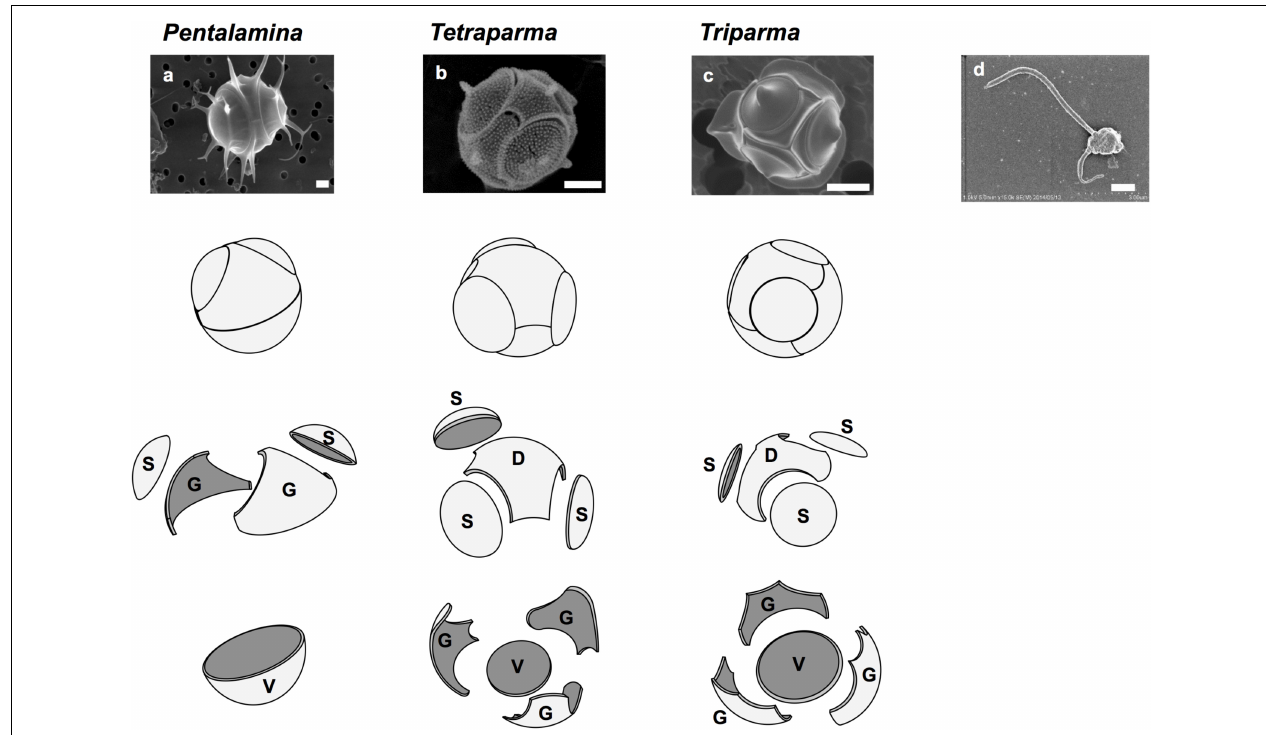
FIGURE 1 | Silicified and flagellated species of Bolidophyceae. (a) Pentalamina corona , (b) Tetraparma pelagica , (c) Triparma laevis f. inornata , and (d) Triparma eleuthera. Scale bars = 1 µ m. Diagrams of silica plates in the three genera of silicified species (Parmales); D, dorsal plate; G, girdle plate; S, shield plate; and V, ventral plate. Redrawn from Booth and Marchant (1987) with